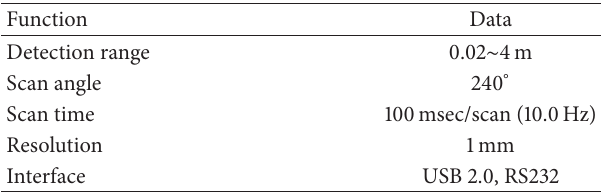
Table 1: Main characteristics of the NAO URG-04LX laser.